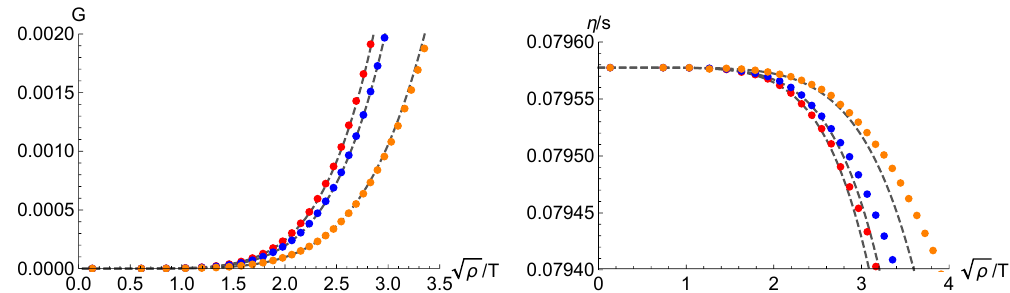
Figure 9 . The comparison between the numerical and analytical results of shear elastic modulus and viscosity in the high temperature limit for K ∈ [ − 1 / 8 , − 1 / 20] (red-orange). The dots are numerical results obtained by (2.16). The gray dashed lines are analytical results obtained by (A.16) √ and (A.21). We have fixed λ = 0 and α/ ρ = 1